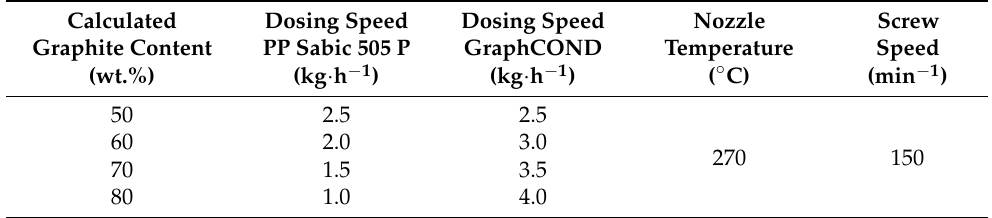
Table 1. Main compounding parameters of the various compound materials.